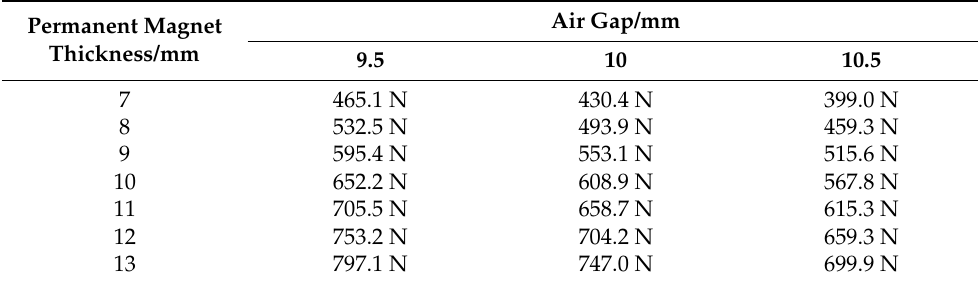
Table 3. Attraction force of permanent magnet near working